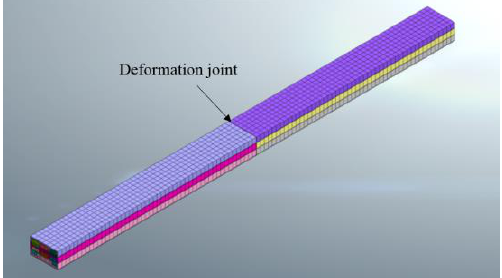
Figure 15. Schematic diagram of deformation joint position.